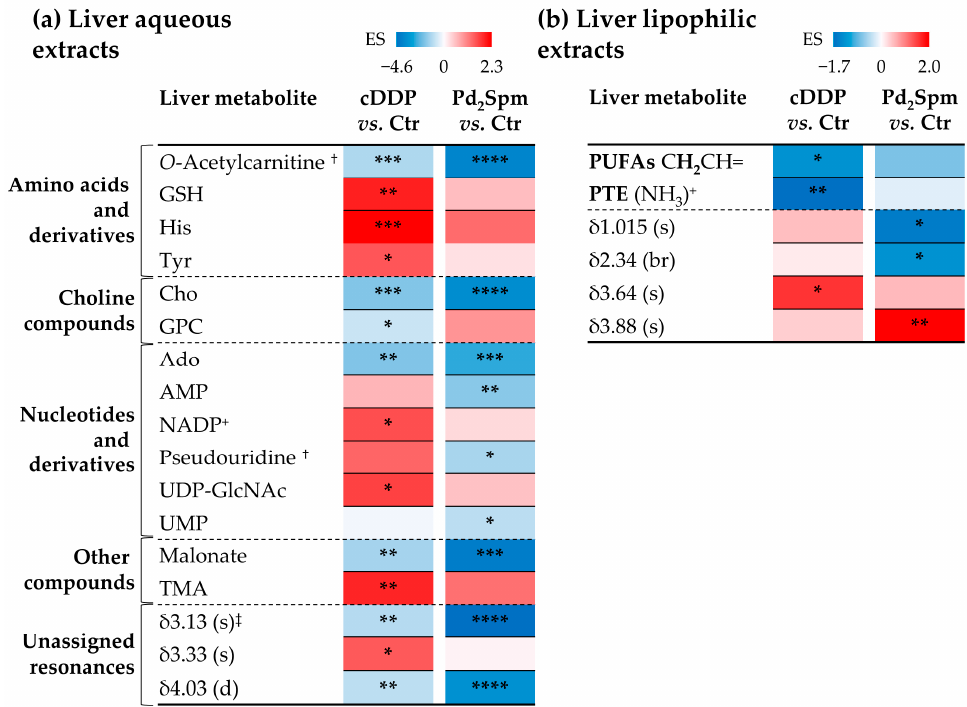
Figure 4. Heatmaps colored according to the effect size (ES) of variations in the ( a ) aqueous, and ( b ) lipophilic extracts of liver of TNBC mice. Abbreviations: NADP + nicotinamide adenine dinucleotide phosphate (oxidized); TMA, trimethylamine; other abbreviations as defined in Figure 1; s, singlet; d, doublet; br, broad signal. † Tentative assignment. ‡ Partial integration of resonance peak. * p -value < 5.0 × 10 − 2 ; ** p -value < 1.0 × 10 − 2 ; *** p -value < 1.0 × 10 − 3 ; **** p -value < 1.0 × 10 − 4 .